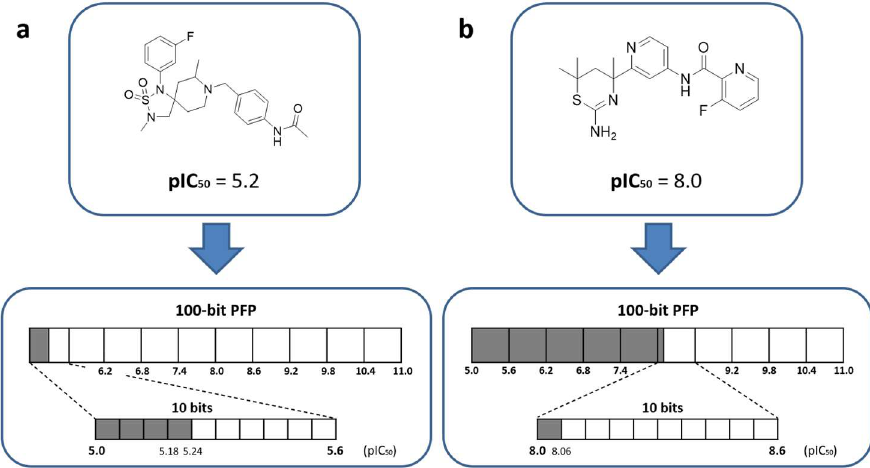
Figure 1. Cumulative potency encoding. ( a ) and ( b ) illustrate how logarithmic potency values of different magnitude are encoded in the potency module of SPFP.